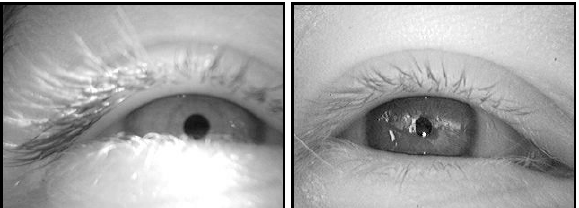
Figure 13. Challenges to corneal reflection tracking. At left, the corneal reflection is not visible (even though the pupil is), but sunlight reflecting off the eyelashes and lower eyelid is bright enough to be mistaken for a corneal reflection. At right, the IRED’s corneal reflection is visible, but is difficult to distinguish from the equally bright environmental